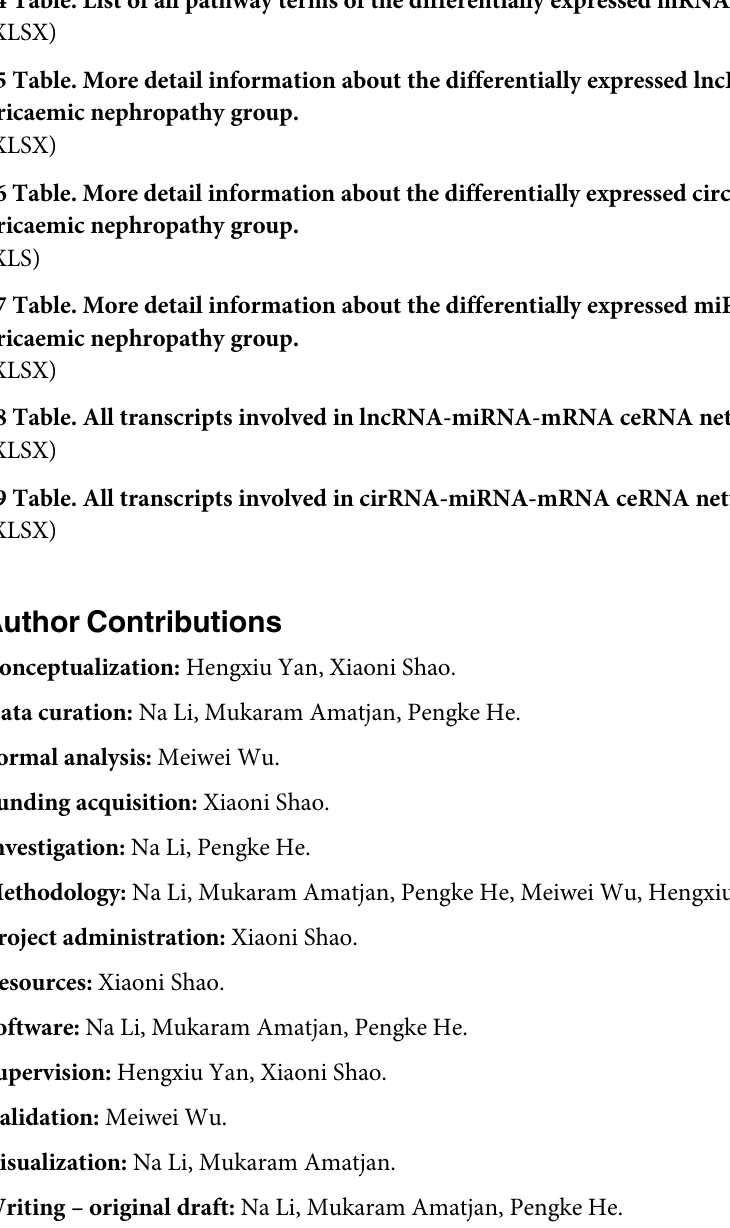
S3 Table. List of all Gene Ontology term of the differentially expressed mRNA. (ZIP) S4 Table. List of all pathway terms of the differentially expressed mRNA. (XLSX) S5 Table. More detail information about the differentially expressed lncRNA in the hyper- uricaemic nephropathy group. S6 Table. More detail information about the differentially expressed circRNA in the hyper- uricaemic nephropathy group. S7 Table. More detail information about the differentially expressed miRNA in the hyper- uricaemic nephropathy group. S8 Table. All transcripts involved in lncRNA-miRNA-mRNA ceRNA network. (XLSX) S9 Table. All transcripts involved in cirRNA-miRNA-mRNA ceRNA network.